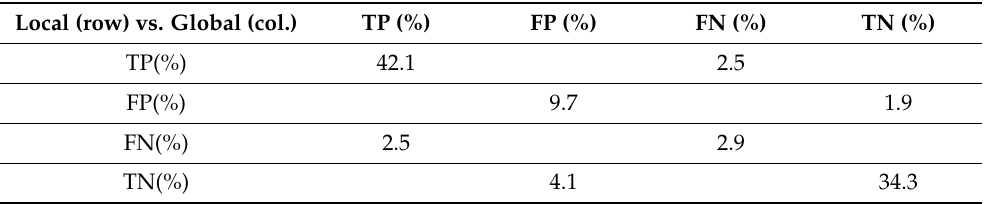
Table 5. Performance of the outcomes for the joint methods. Empty cells correspond to impossible combinations of outcomes.